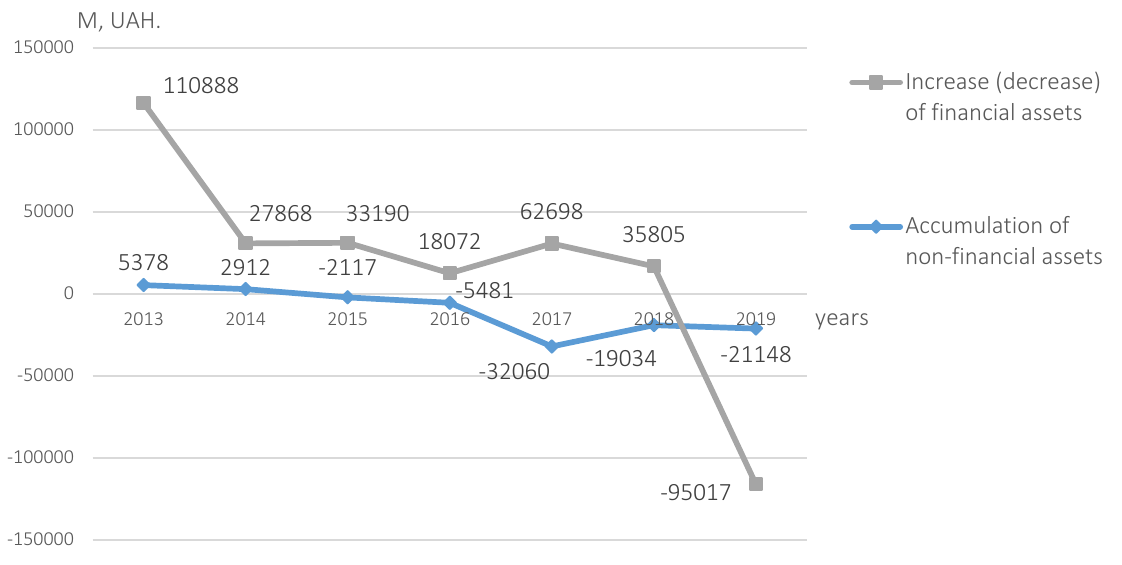
Figure 1. Dynamics of the increase (decrease) of people’s assets in Ukraine in 2013–2019, UAH